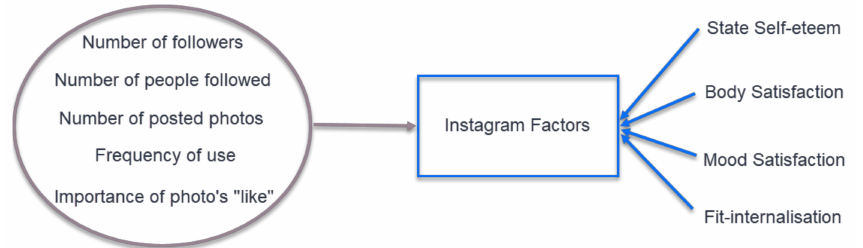
Figure 2. Simple regression statistical analysis between Instagram factors and state self-esteem, body satisfaction, mood satisfaction and